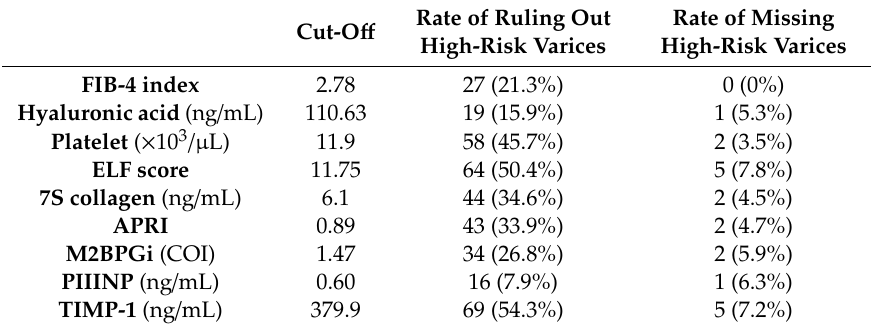
Table 5. Rate of ruling out and missing high-risk varices in the estimation cohort ( n = 127). Cut-O